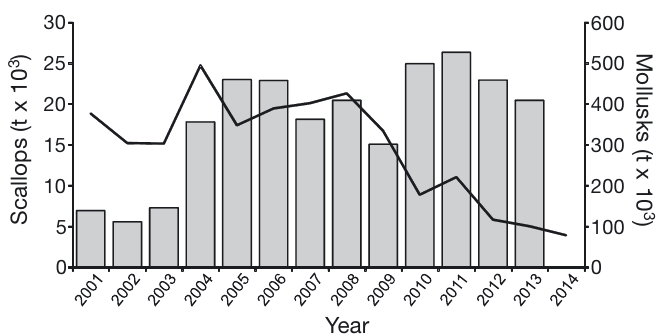
Fig. 1. Landings of Argopecten purpuratus (black line) and total mollusks harvested in Chile for the period 2001 to 2014 (source: Servicio Nacional de Pesca, www.sernapesca.cl; accessed 4 June